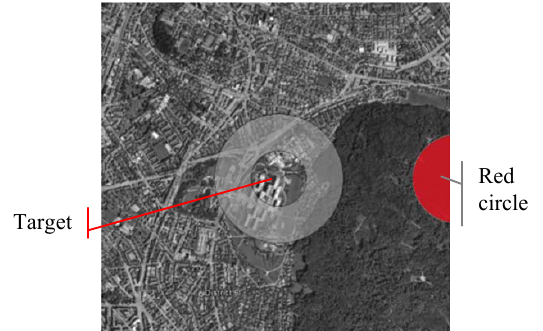
Figure 8. Task setting for panning: drag the red circle inside the grey border (fixed position).